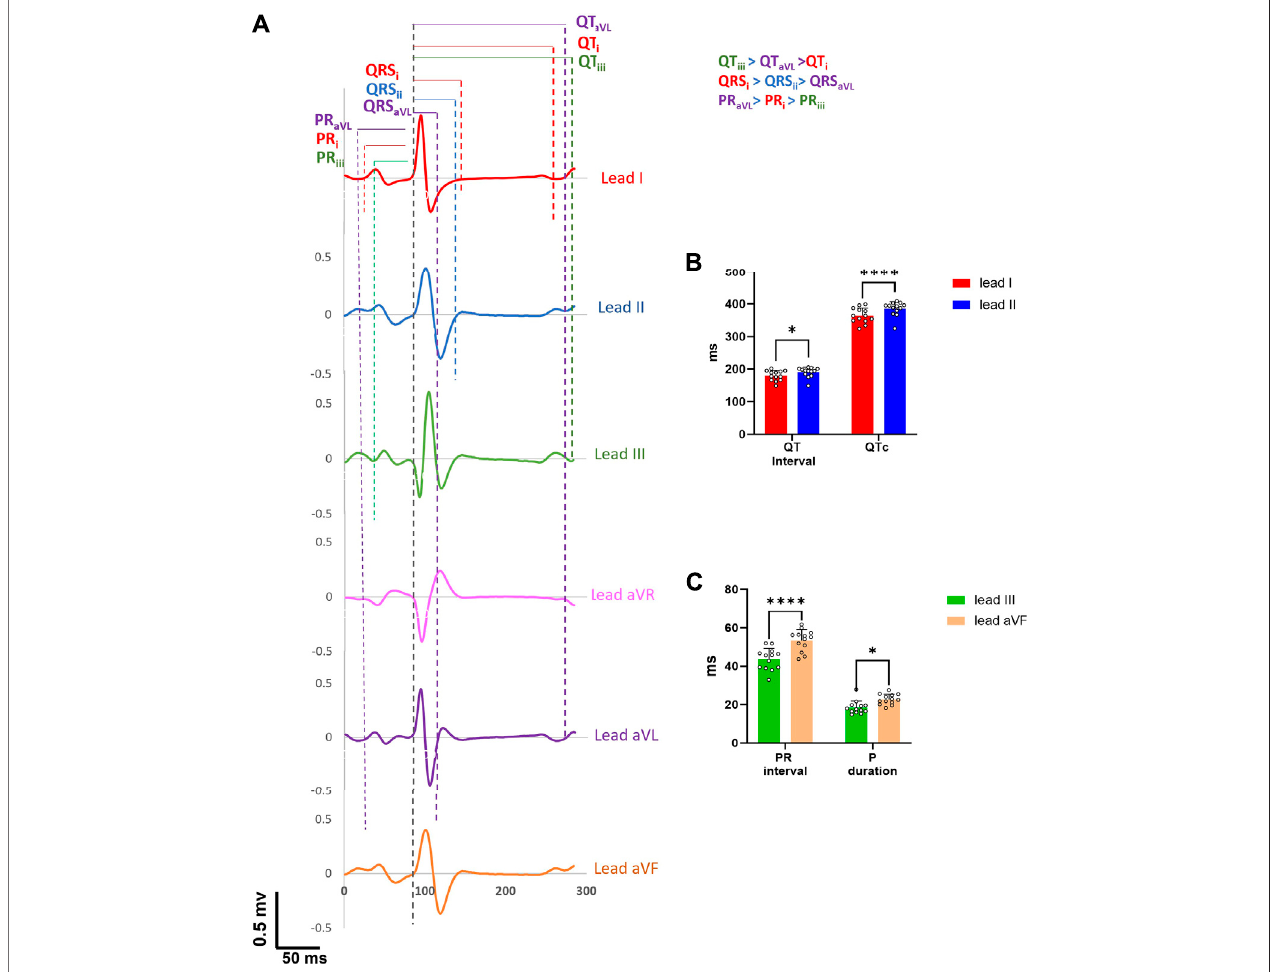
FIGURE 4 | Inter-beat variability on ECG parameters. (A) . One representative beat from six frontal leads of a young guinea pig show marked differences in ECG parameter values. (B) . QT intervals and QTc intervals in lead II are signi fi cantly longer than in lead I (n = 13). (C). PR interval and p duration measured in lead aVF are signi fi cantly longer than lead III. 2-way ANOVA with 0.05 FDR cutoff was used to calculate the p values. p p < 0.05, pppp p < 0.0001.